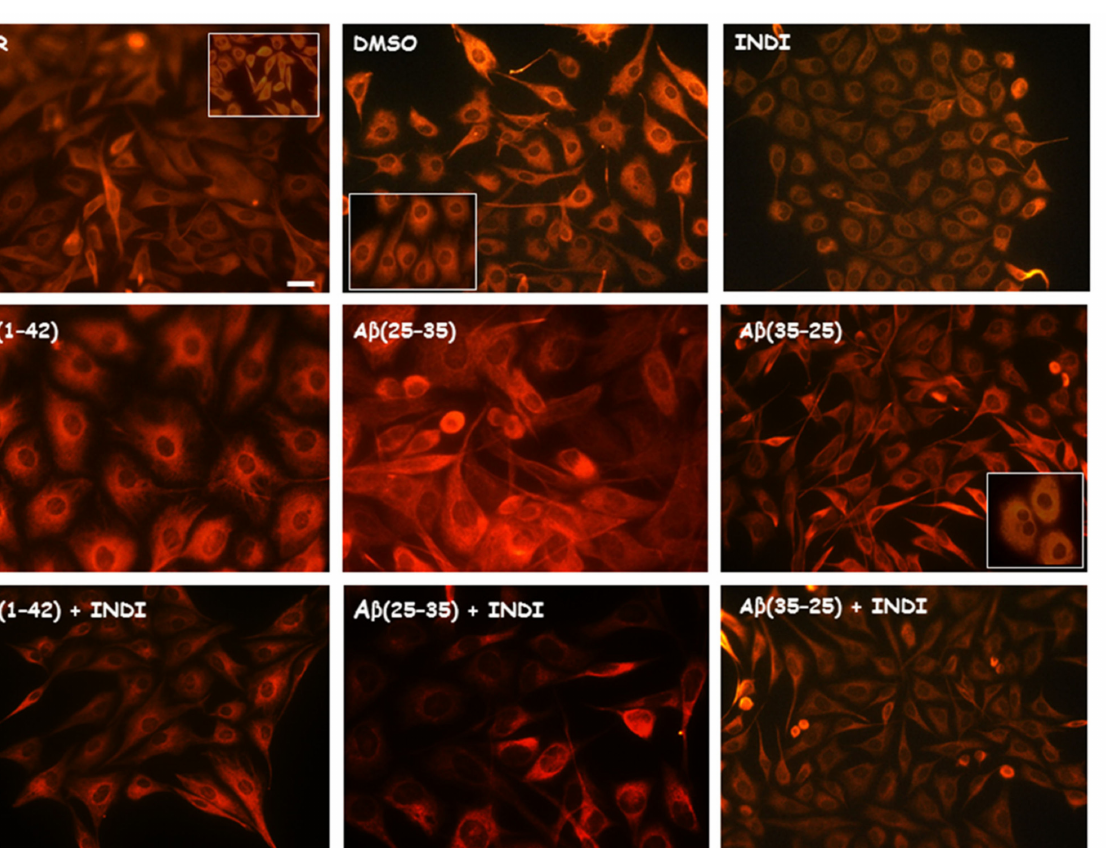
Figure 2. Immunocytochemistry for anti-Vimentin in OECs. Images show different conditions: control, DMSO, 100 µ M Indicaxanthin (INDI), 10 µ M A β (1-42) or A β (25-35) or A β (35-25) both in the absence and presence of 100 µ M indicaxanthin for 24 h. Scale bar 20 µ